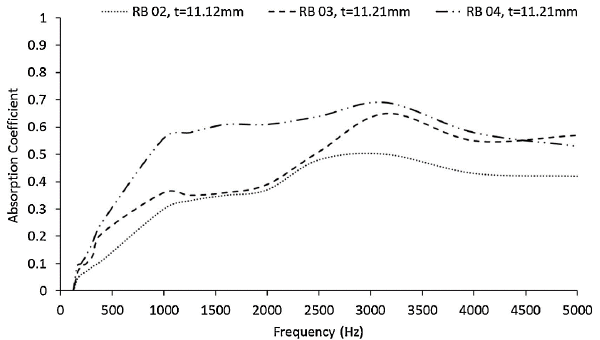
Figure 15. Sound absorption coefficient curves of rubber aerogels at different fiber concentrations (2.0, 3.0, and 4.0 wt.%) [109].